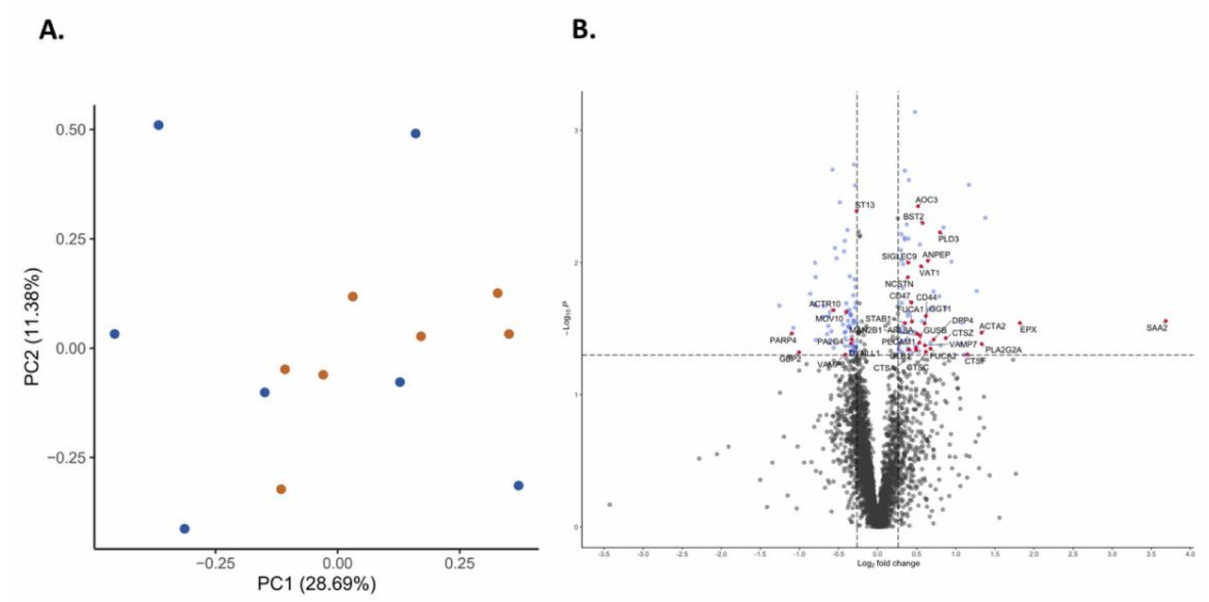
Figure 2. Principal component analysis showing data distribution in patients with acute kidney injury (blue) and without renal impairment (red) ( A ) and volcano plot indicating the proteins (red dots) showing both the magnitude of fold changes ( x axis) and high statistical significance (-log10 of p values, y axis) ( B